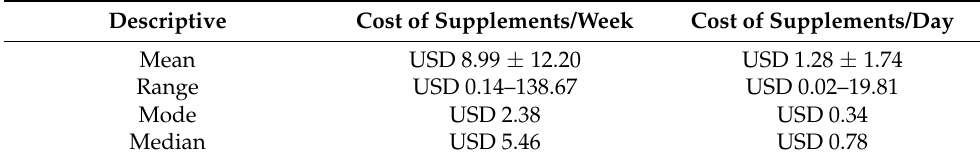
Figure 3. Sub-reasons of dietary supplement intake reported for ( a ) primary medical condition and ( b ) symptom control category among older cancer survivors ( n = 215).